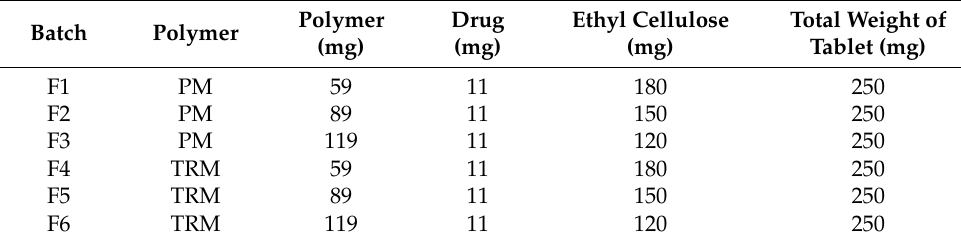
Table 2. The formulation of bilayer tablets of ivabradine hydrochloride.